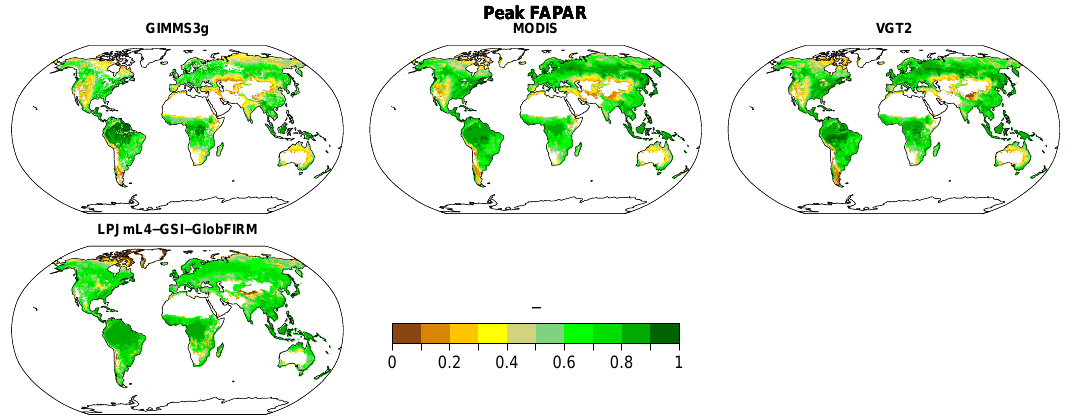
Figure 11. FAPAR mean annual peak comparison with three different remote sensing